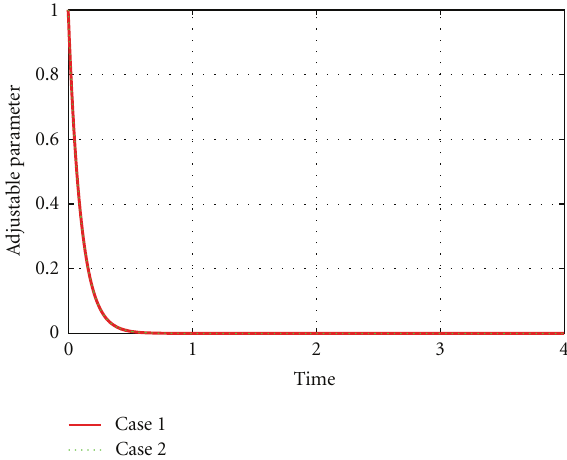
Figure 3: Time histories of the state variable x 3 ( t ).